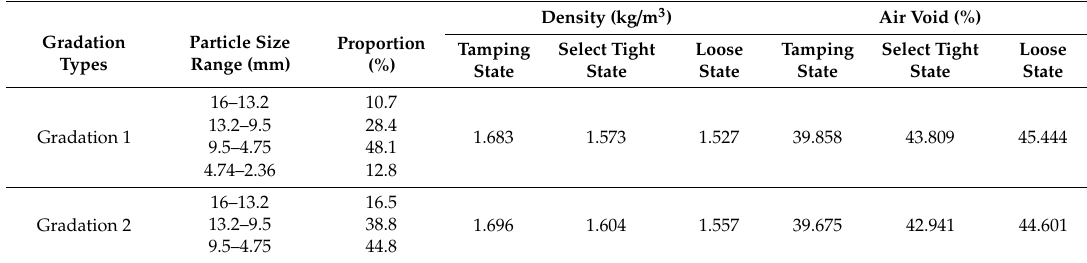
Table 6. Calculation results of the sieve pass rate of the coarse aggregate.